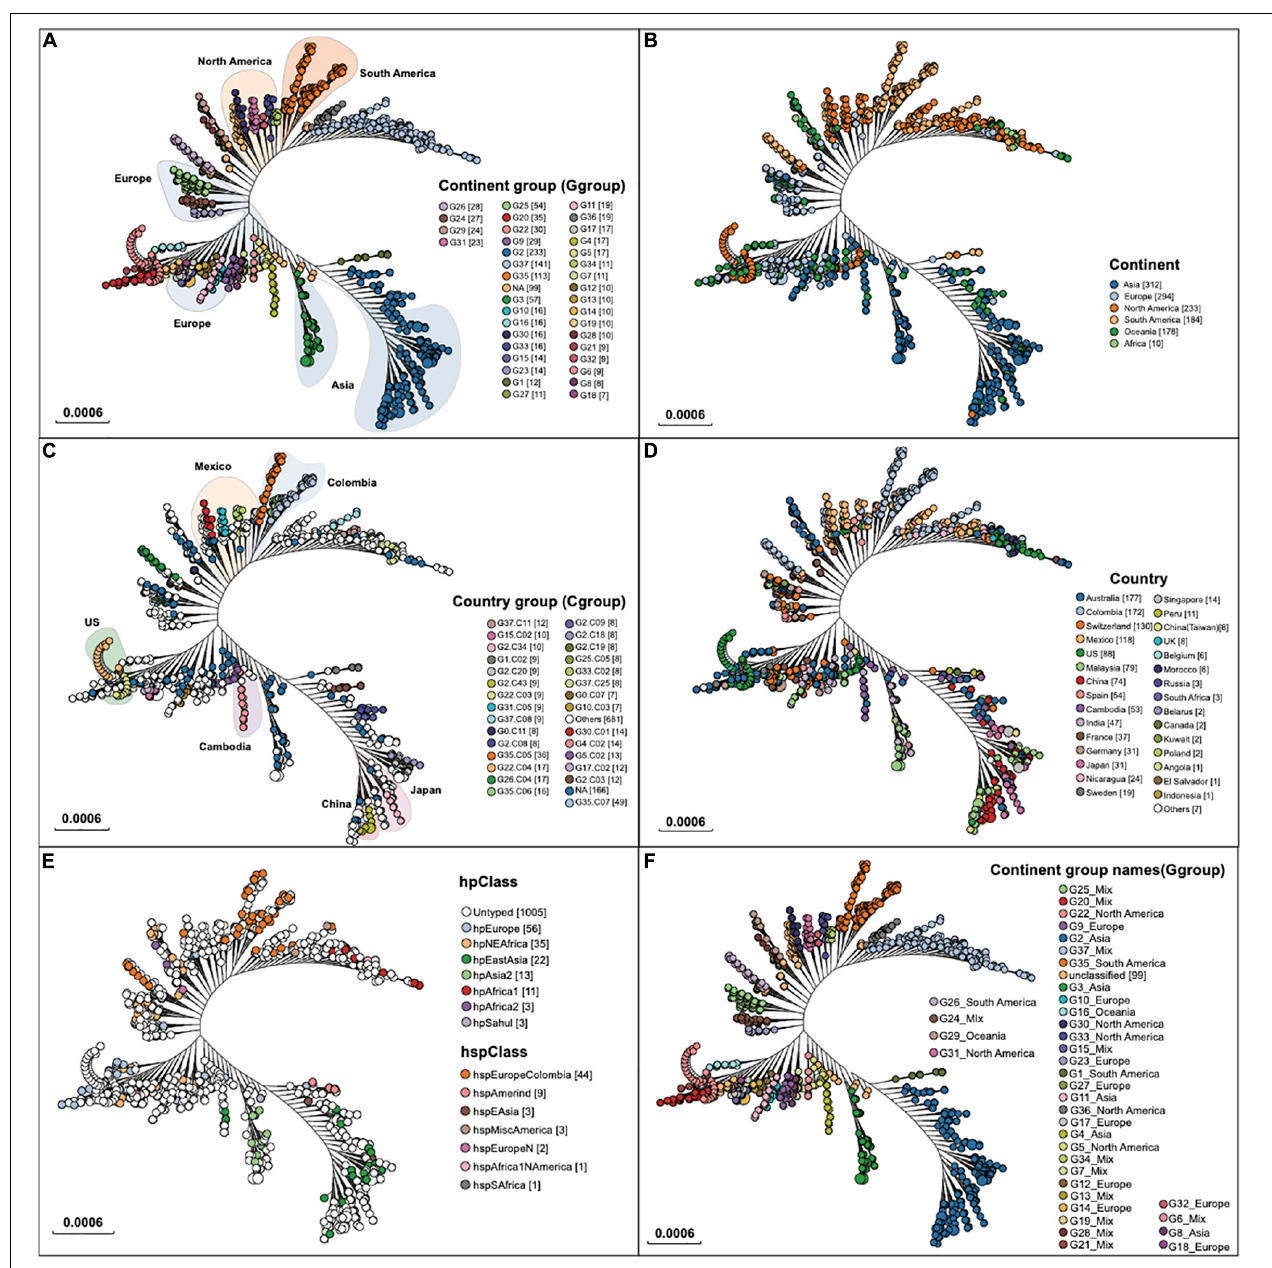
FIGURE 1 | Two clades of geographic typing based on the WGS. The Hp TT enrolled 1,211 H. pylori genomes downloaded from NCBI. The clade nodes in each figure correspond to (A) G groups for continent level of typing, (B) the continent that isolates collected from, (C) C groups for country-level typing, (D) the country that isolates were collected from. (E) the hp Class and hsp Class, (F) G groups for continent level of typing with group names. Numbers in parenthesis refer to the number of isolates in each